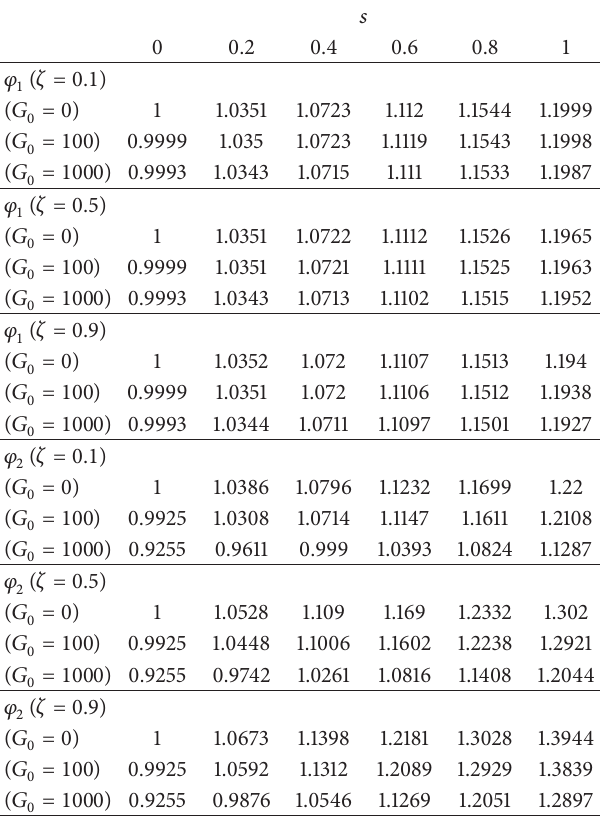
Table 5: Effects of shear foundation modulus of Pasternak layer on the steady-state vibration amplitudes ratios 𝜑 1 and 𝜑 2 for different compressive axial ratio 𝜁 .